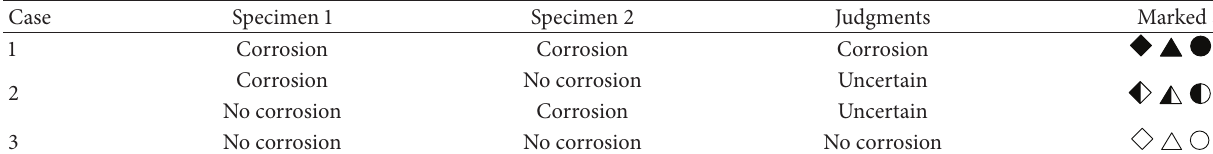
Table 3: Corrosion judgment defined in this study.